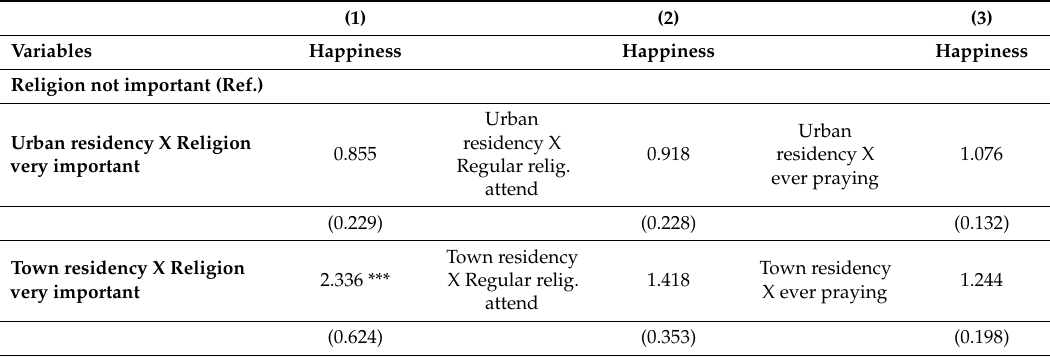
Table 5. The association between religiosity / religious practices and happiness among various residential statuses (ordered logistic model, odds ratios